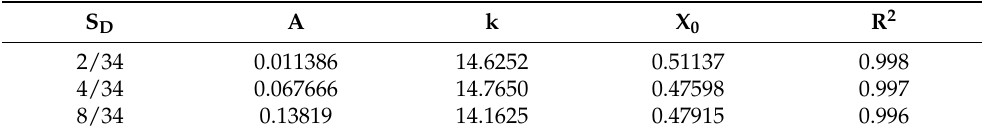
Figure 5. The surface plots of the function (4) approximating experimental data (blue circles) for: ( a ) S V = 2 μ L; ( b ) S V = 4 μ L; ( c ) S V = 8 μ L. Color bar scale for C D . Table 1 summarizes parameters of Equation (4) experimentally determined for different values of SV. Table 1. Parameters of Equation (4) estimated from the experimental